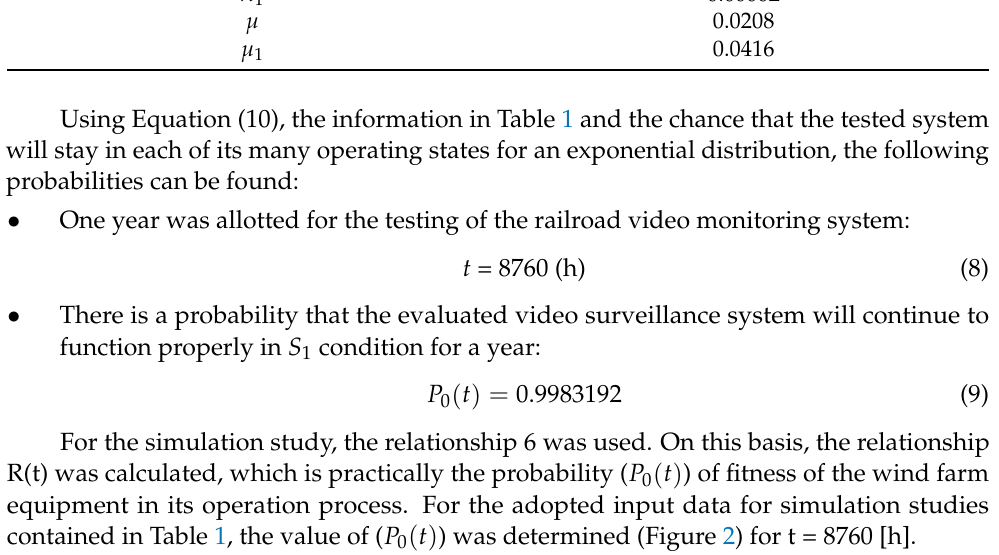
Table 1. Metrics for system dependability.